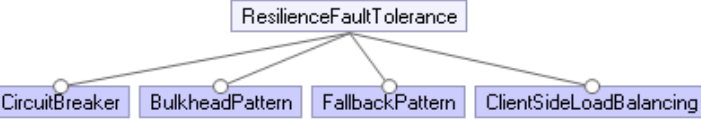
Figure 12. Feature diagram of resilience and fault